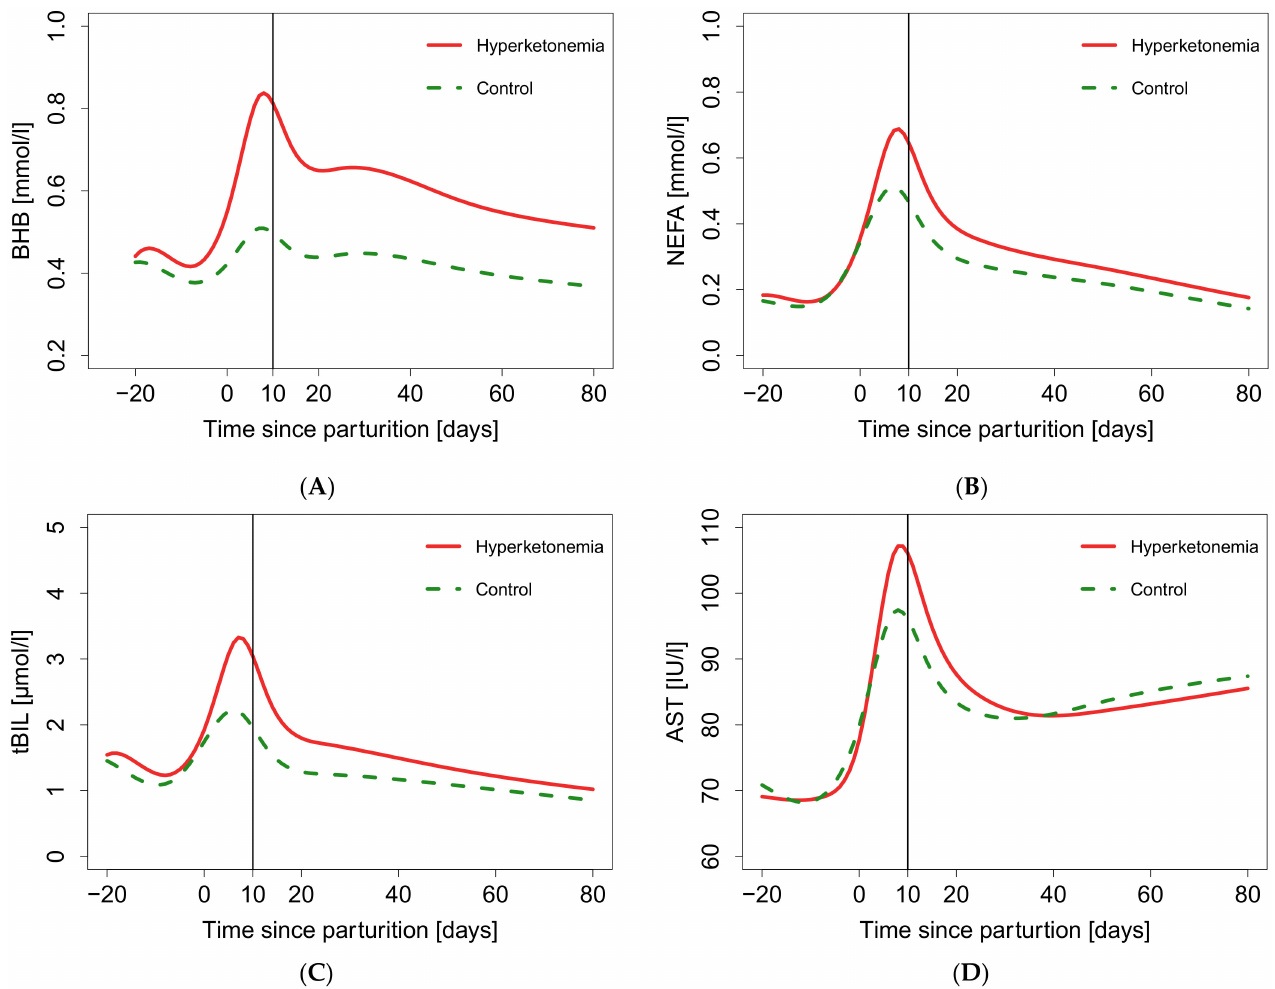
Figure 2. Natural cubic spline fit of biomarkers for hyperketonemia (BHB > 0.8 mmol/L) and control (BHB ≤ 0.8 mmol/L) group between 20 days ante partum and 80 days post partum. The 10th day p.p. is indicated by a vertical line: ( A ) Natural cubic spline fit of beta-hydroxybutyrate (BHB); ( B ) Natural cubic spline fit of non-esterified fatty acids (NEFA); ( C ) Natural cubic spline fit of total bilirubin (tBIL); ( D ) Natural cubic spline fit of aspartate aminotransferase